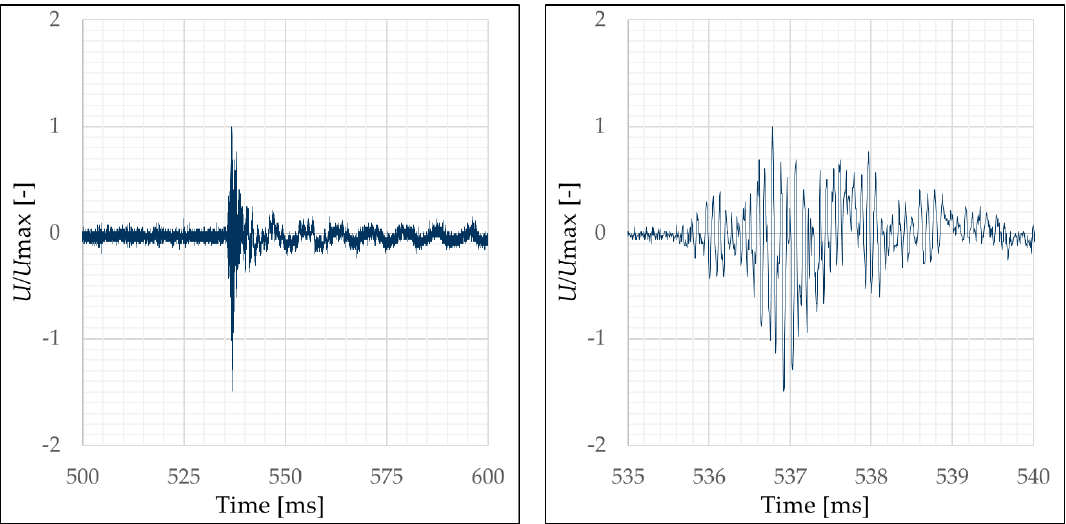
Figure 11. Signal measured with acceleration sensor ACC1, uncalibrated but normalized with the maximum value (detailed visualization of the maximum and minimum peak values in the right diagram), complete signal ( left ) visualization of the first peak ( right ); graphic: Hering [17].